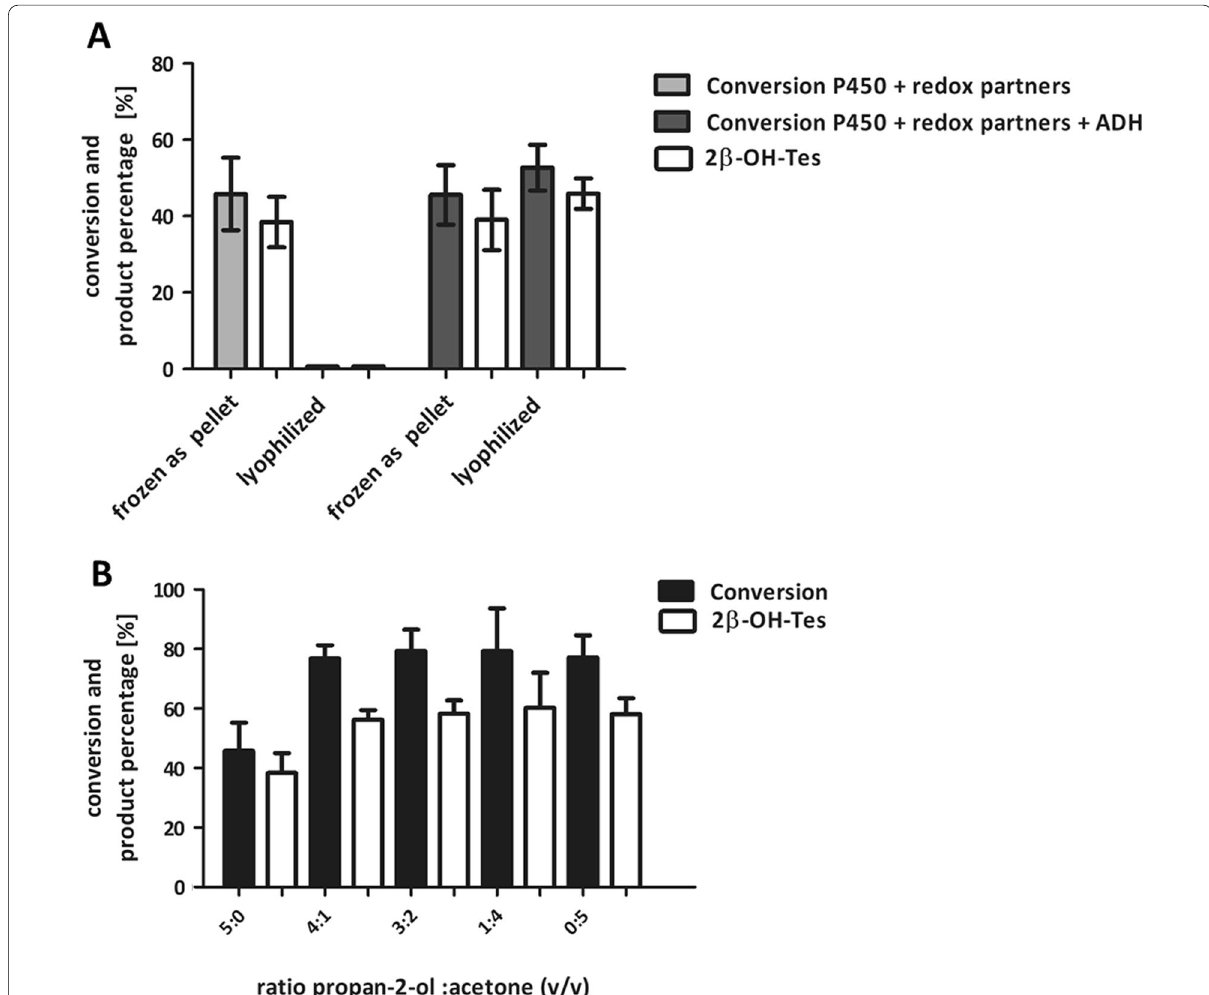
Fig. 5 A Influence of cofactor regeneration by Re-ADH in E. coli C43 (DE3) pET22b- cyp105D pCOLADuet- pdx - pdr-adh on testosterone 1 + conversion and formation of 2β-hydroxytestosterone 2 (2β-OH-Tes). B Effect of different ratios of propan-2-ol and acetone on testosterone 1 conversion and formation of 2β-OH-Tes mediated by the wet cells without ADH (P450 redox partners). The best performing wet cell biocatalyst + (`frozen as cell pellet’) was investigated (see Fig. 3). Reaction conditions: 10 mg/mL lyophilized cells or 50 mg/mL wet cells in 0.5 mL Phosphate Sucrose EDTA (PSE)-buffer with 1 nutrient solution, pH 7.5 in 2 mL reaction tubes; 1 mM testosterone 1 dissolved in 5% co-solvent (v/v) final × concentration, 25 °C, 1100 min − 1 shaking frequency, reaction time 20 h. All measurements were performed in technical duplicates. In case a